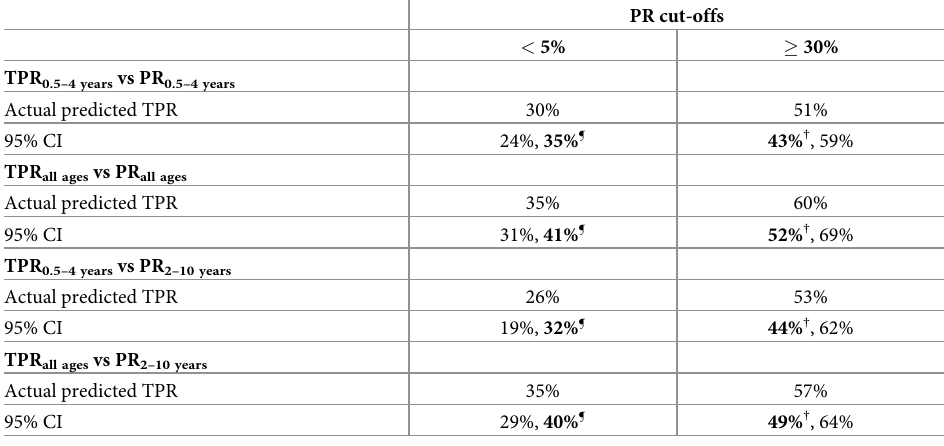
¶ For low transmission settings, the upper confidence limit of predicted TPR range was used as the conservative allocation of the maximum probable TPR as a proxy measure for PR < 5%, † while for high transmission settings, the lower confidence limit of the predicted TPR range was used as a conservative allocation of the minimum probable TPR as a proxy measure for PR �